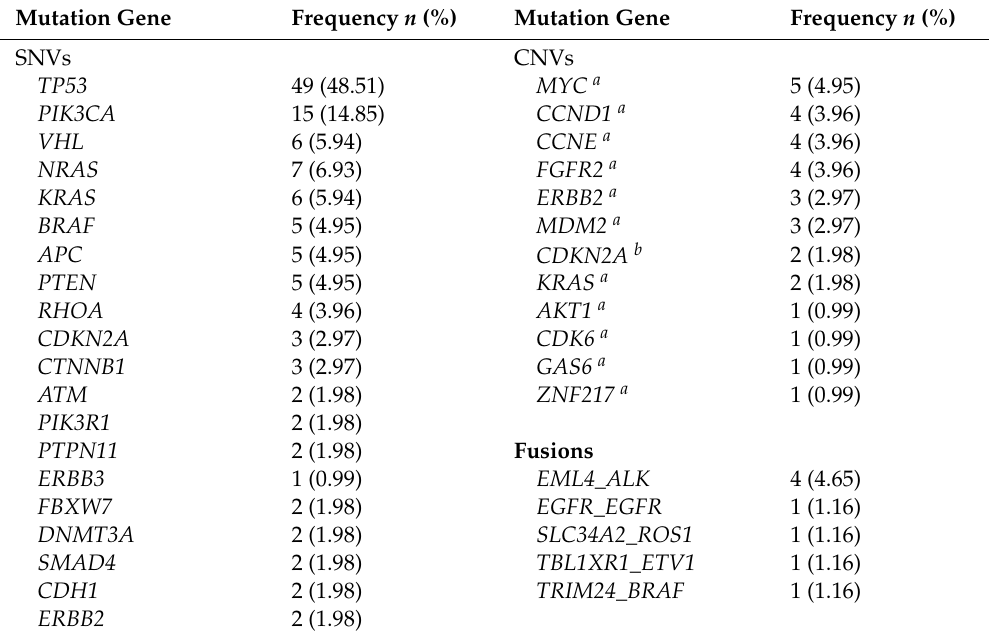
Table 3. Frequent gene alterations in FORCE-1patients.